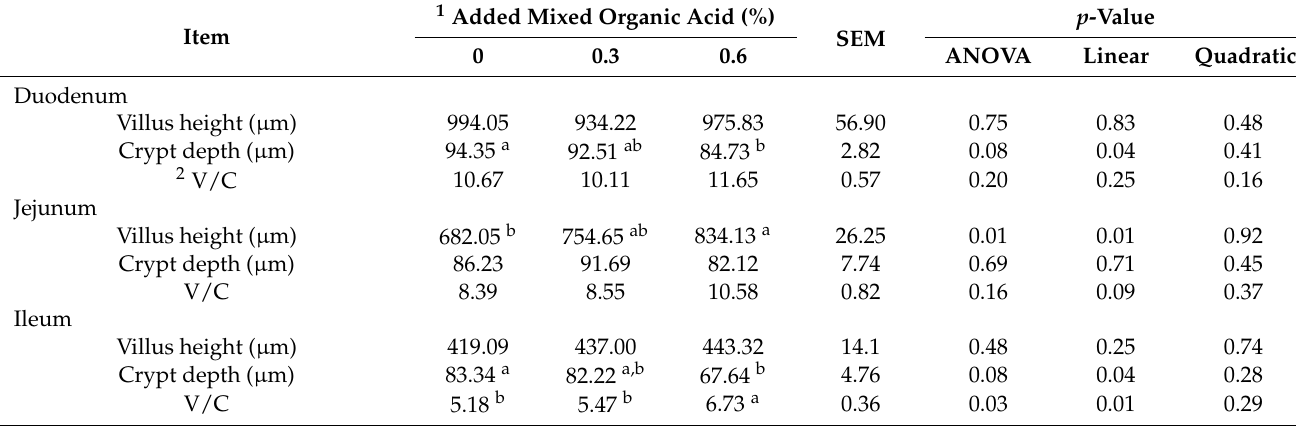
Table 6. Small intestine morphology of 21 d broiler chickens as affected by dietary MOA supplementation.